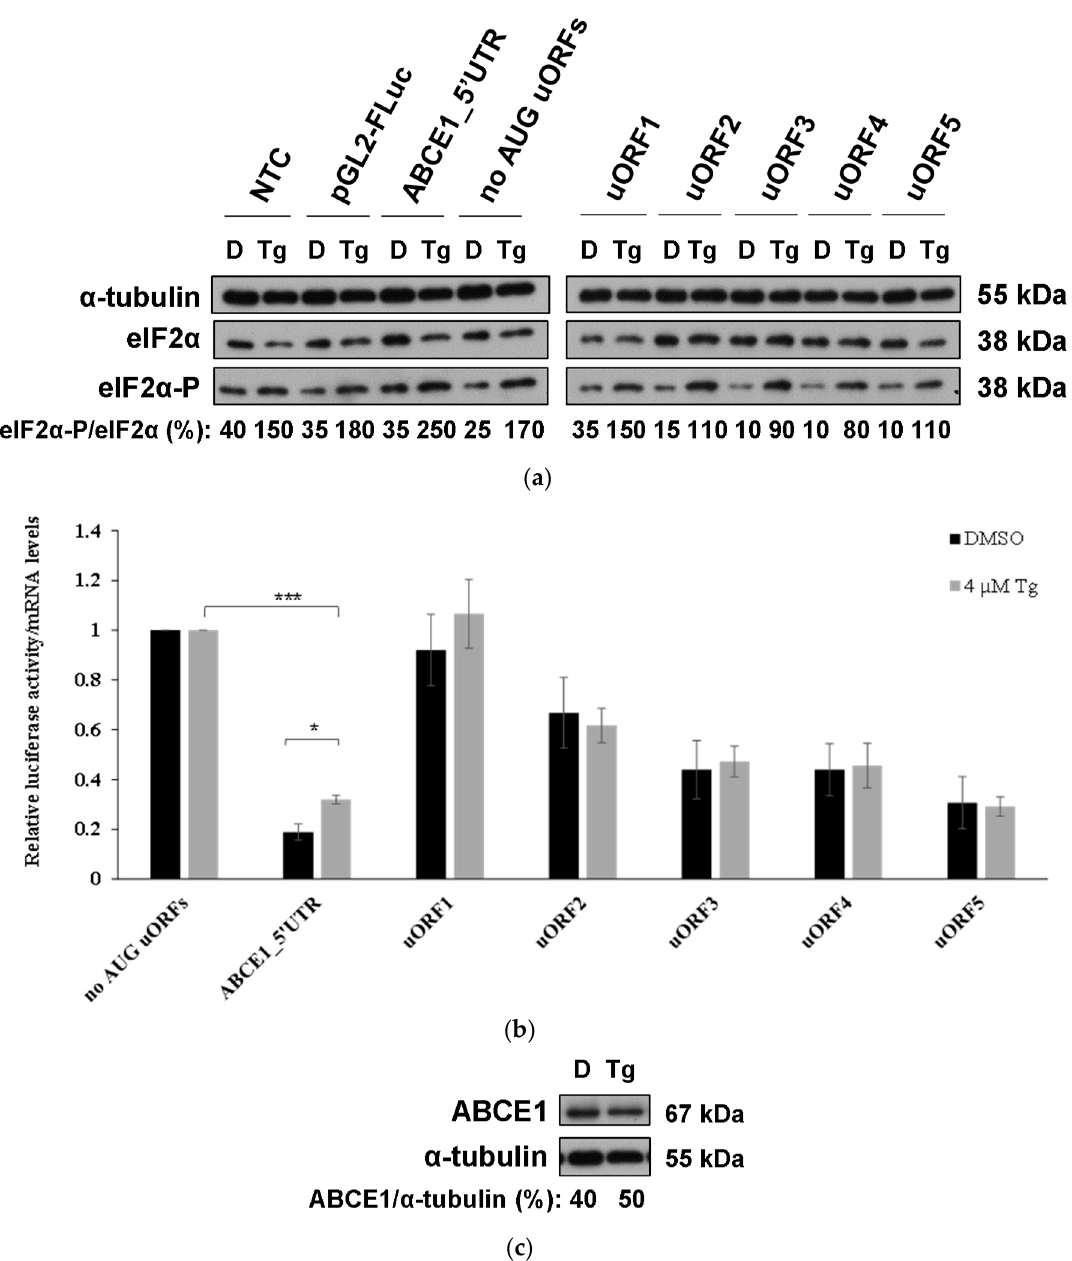
Figure 9. ABCE1 AUG uORF-mediated translational repression is partially alleviated under ER stress induced by thapsigargin (Tg). HCT116 cells were transiently co-transfected with each one of the constructs described in Figure 2a and the pRL-TK plasmid. Four hours post-transfection, cells were treated with 4 µM of thapsigargin (Tg; gray bars) or the vehicle control of Tg (DMSO; black bars) for 24 h and then harvested and lysed. ( a ) The ER stress induced by Tg was assessed by Western blot using specific antibodies against eIF2 α -P and the counterpart, eIF2 α . Alpha-tubulin was used as a loading control. These are representative immunoblots from at least three independent experiments. NTC–non-transfected control. ( b ) Luciferase activity was assessed by luminometry assays (upper panel), and the corresponding luciferase mRNA levels by semi-quantitative RT-PCR (lower panel), and the relative expression was analyzed as described in Figure 2b legend. ( c ) The expression of endogenous ABCE1 protein was assessed in the absence (D, DMSO) or presence (Tg; tapsigargin) of ER stress induced by Tg, using specific antibodies against ABCE1. Alpha-tubulin was used as a loading control. The results are presented as mean ± SEM from at least three independent experiments. Student’s t-test was applied for statistical significance: p < 0.05 (*), and p < 0.001 (***).